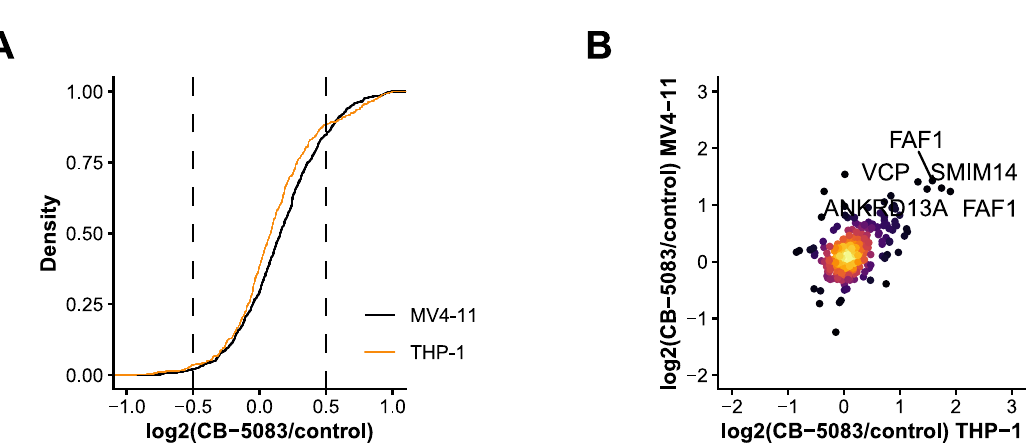
Fig 2. Dynamics of the ubiquitin-modified proteome in AML cells after VCP inhibition. (A) SILAC ratio distribution of all quantified ubiquitylation sites in MV4-11 and THP-1 cells. (B) Scatter plot showing SILAC ratios of quantified ubiquitylation sites in MV4-11 and THP-1 cells after treatment with the VCP inhibitor